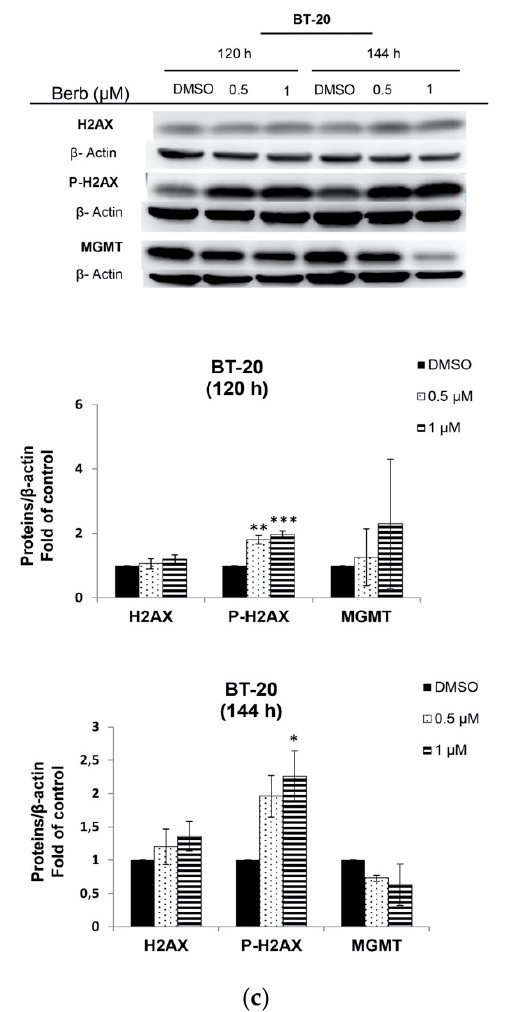
Figure 5. The effects of berberine treatment on the phosphorylation of H2AX and the expression of MGMT proteins of TNBC cell lines ( a ) MDA-MB-468, ( b ) HCC70 and ( c ) BT-20 at 120 h and 144 h. Representative Western blot results of three independent experiments. Berberine doses: 0.5 and 1 µM. ± SD, * p < 0.05, ** p < 0.01 and *** p < 0.001 compared to DMSO. Berb—Berberine.